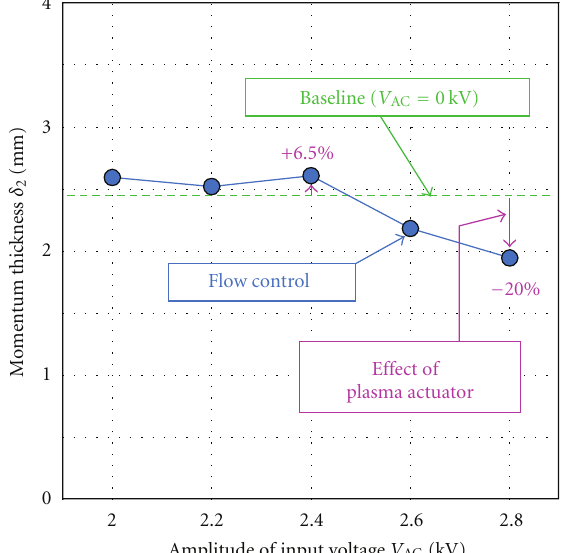
Figure 16: Momentum thickness of boundary layer near trailing edge ( x = 99.1 mm).